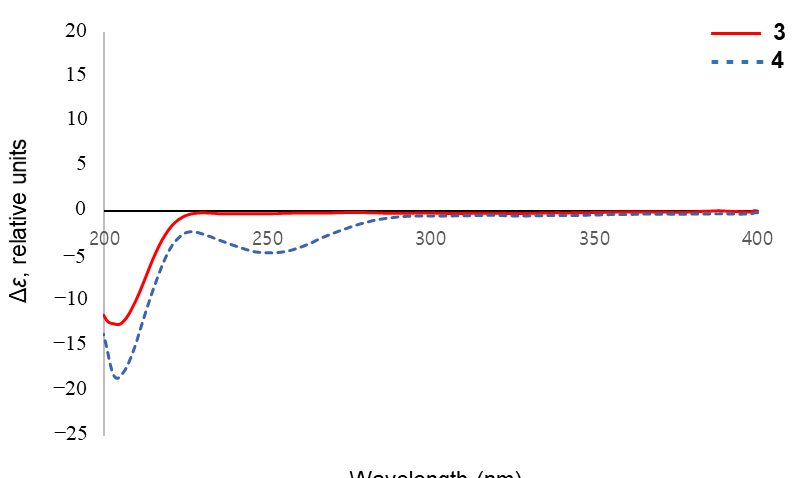
Figure 3. The key NOESY correlation of compounds 3 and 4 .